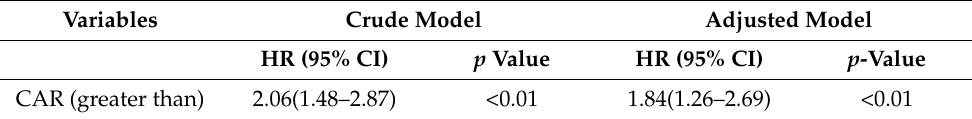
Table 4. Hazard ratio of chemotherapy interruption according to CAR .